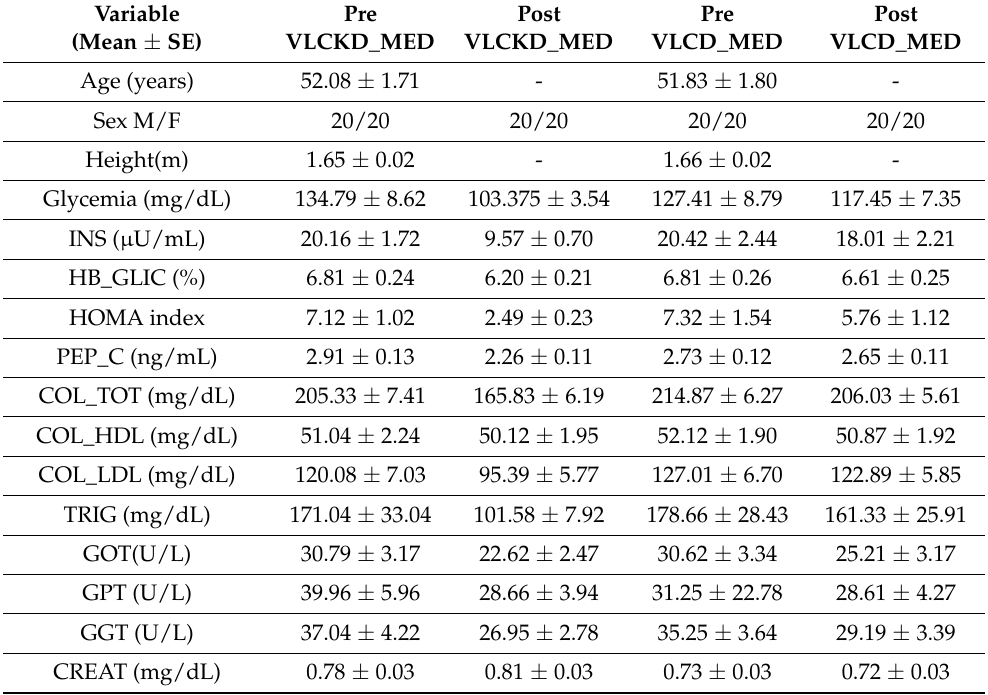
Table 6. Blood chemistry dependent variables before and after the VLCKD_MED and